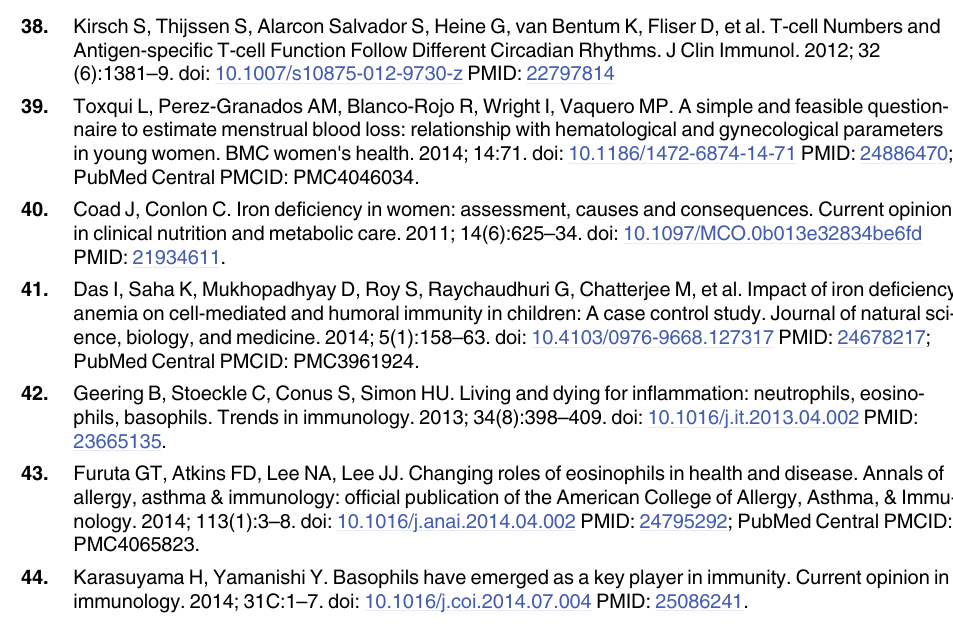
PLOS ONE | DOI:10.1371/journal.pone.0146196 January 5,